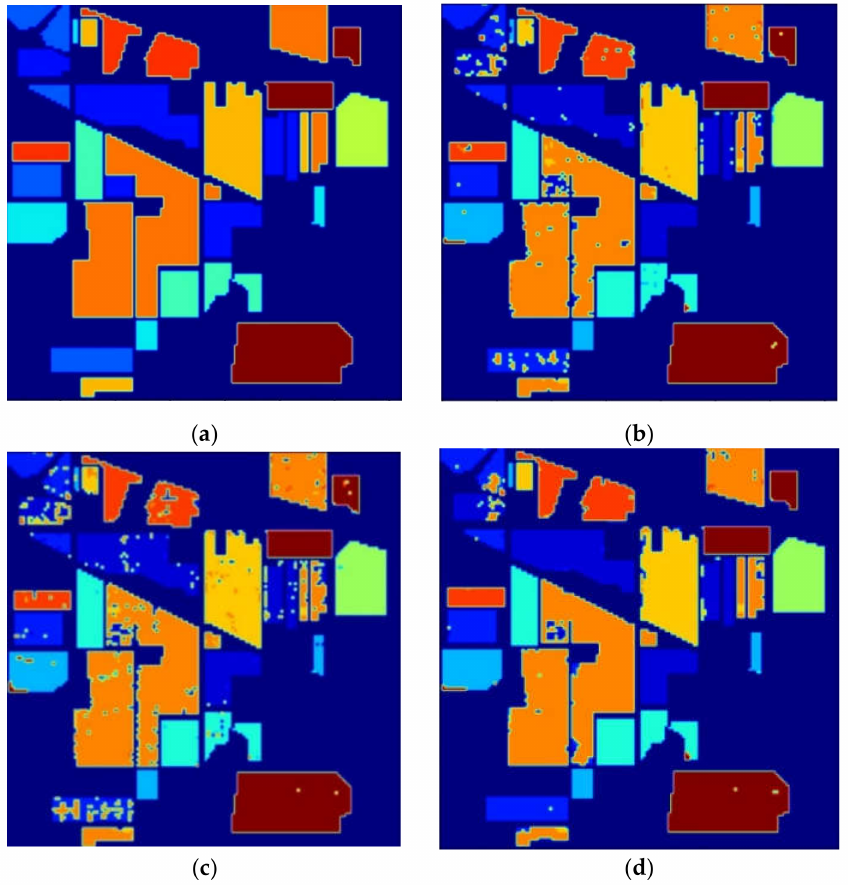
Figure 13. Classification maps obtained for the Indian Pines dataset with a controlled sampling strategy based on the 3 × 3 (w3) window size for the training set, for N = 1 wavelet transform level and LBP riu2 ( a ) Reference map, ( b ) TV filtering, ( c ) CSSWHTV filtering, ( d ) anisotropic diffusion and 8,1 shock filter-based